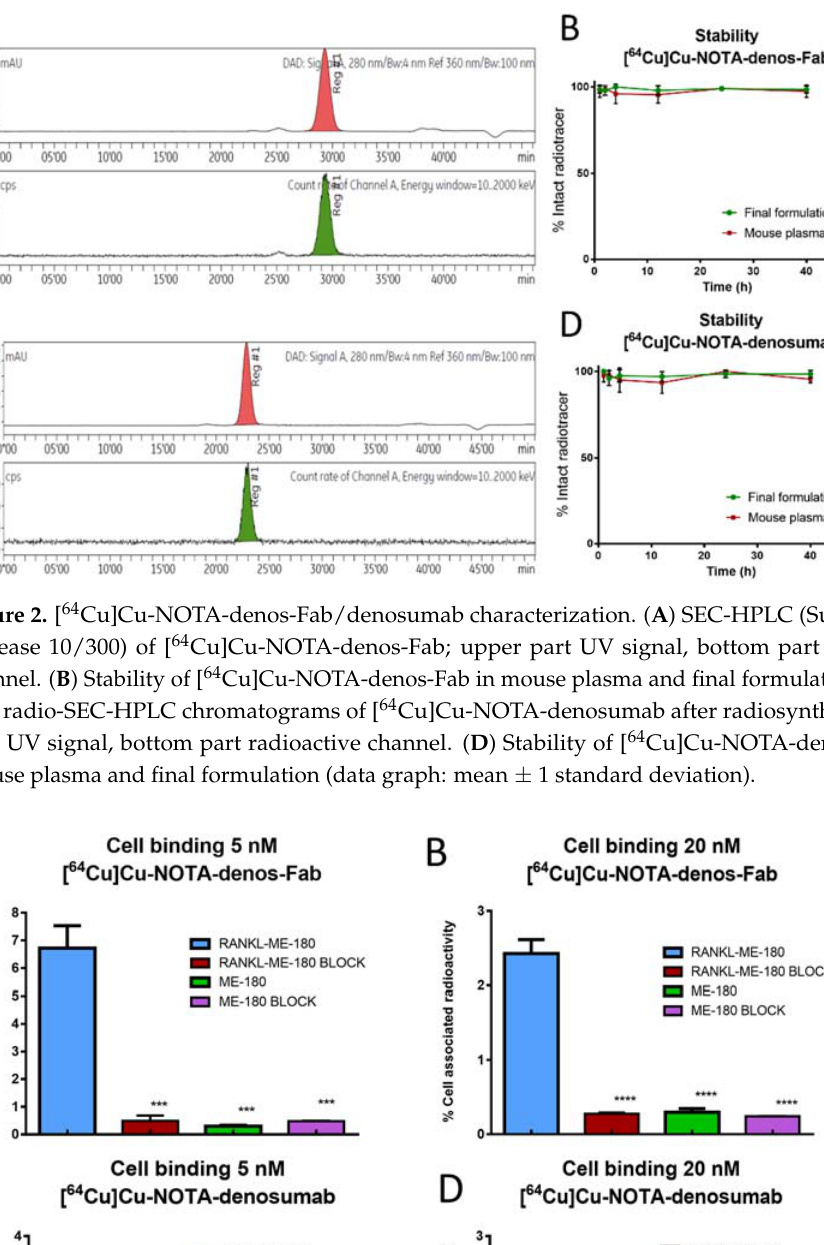
Non ‐ Decay Corrected Yields (%) Apparent Specific Activity (MBq/ μ g) Radiochemical Purity (%)